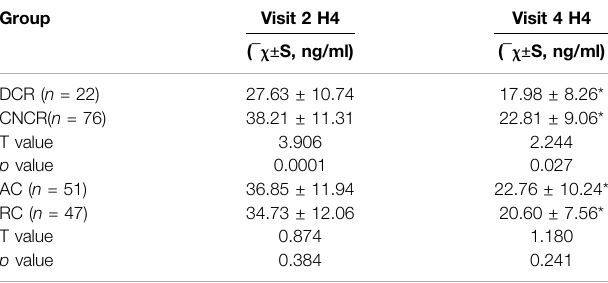
TABLE 5 | Comparison of H4 in different time periods in CI patients. Group Visit 2 H4 Visit 4 H4 ( ‾ χ ± S, ng/ml) ( ‾ χ ± S, ng/ml) DCR ( n (cid:2) 22)